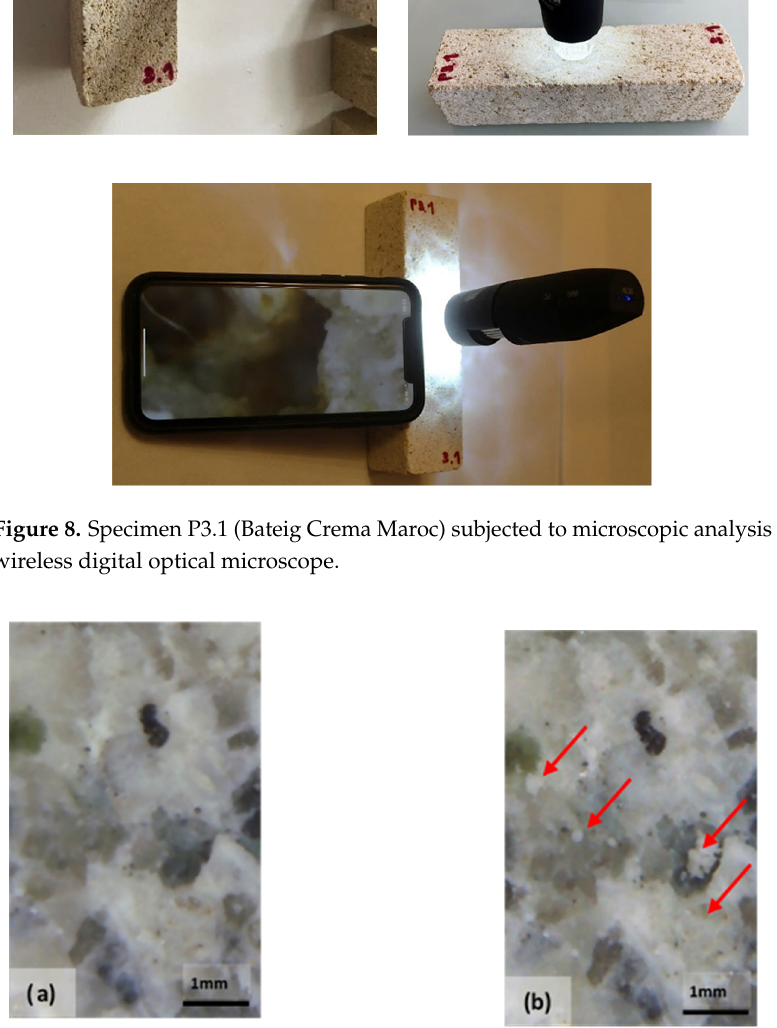
Figure 9. Optical photomicrograph: area of the specimen made of Bateig Blue variety stone ( a ) not treated with the bioconsolidant MYXOSTONE M3P ( b ); area of the same specimen subjected to the bioconsolidation. The arrows indicate the formation of calcite crystals four weeks after the start of treatment ( b ).